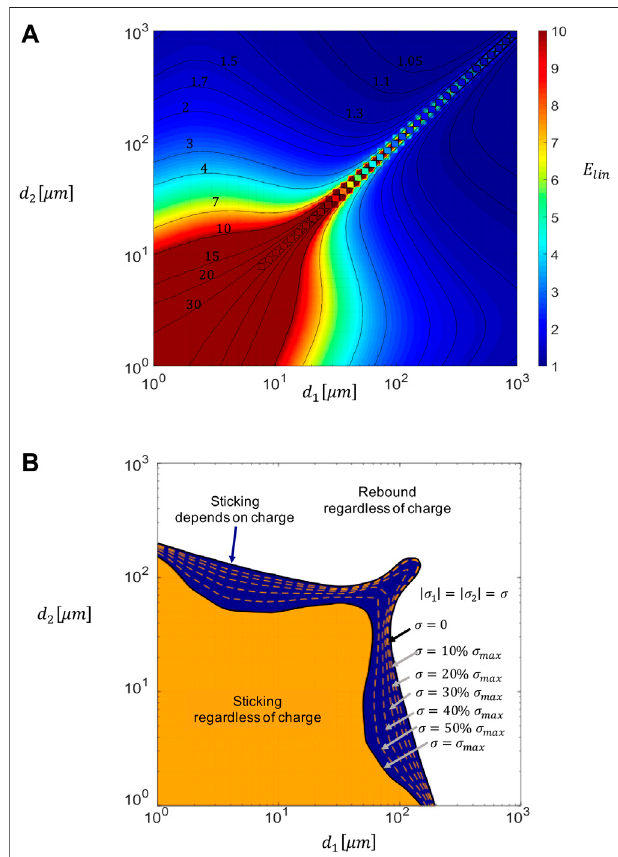
FIGURE 3 | (A) Linear collision effciency map and (B) sticking map for objects charged at their ionization limit colliding at 10 km characterized by a densityof2500kg / m 3 andasurface energy of20mJ / m 2 . d 1 and d 2 represent the diameter of the colliding objects. Isolines in Figure 3A are drawn in correspondence of object size combinations which result in the same collision effciency.Theyellowareaofthestickingmap (Figure3B) representstheregion wherecollisionresultsinstickingregardlessoftheobjectcharge.Thebluearea represents the region in which the outcome of the collision depends on object charge. The white area represents the region where colliding objects